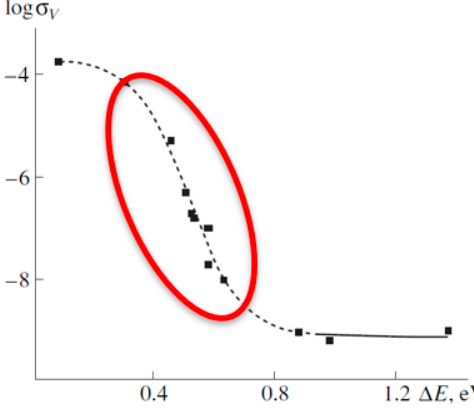
Figure 9. Conductivity as a function of energy corresponding to the position of the total absorption edge. Reprinted with permission from Springer Nature [33] Copyright 2006.